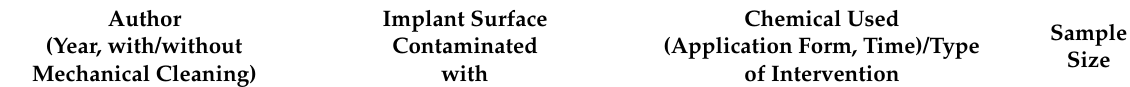
Table 2. Details of the selected studies for systematic